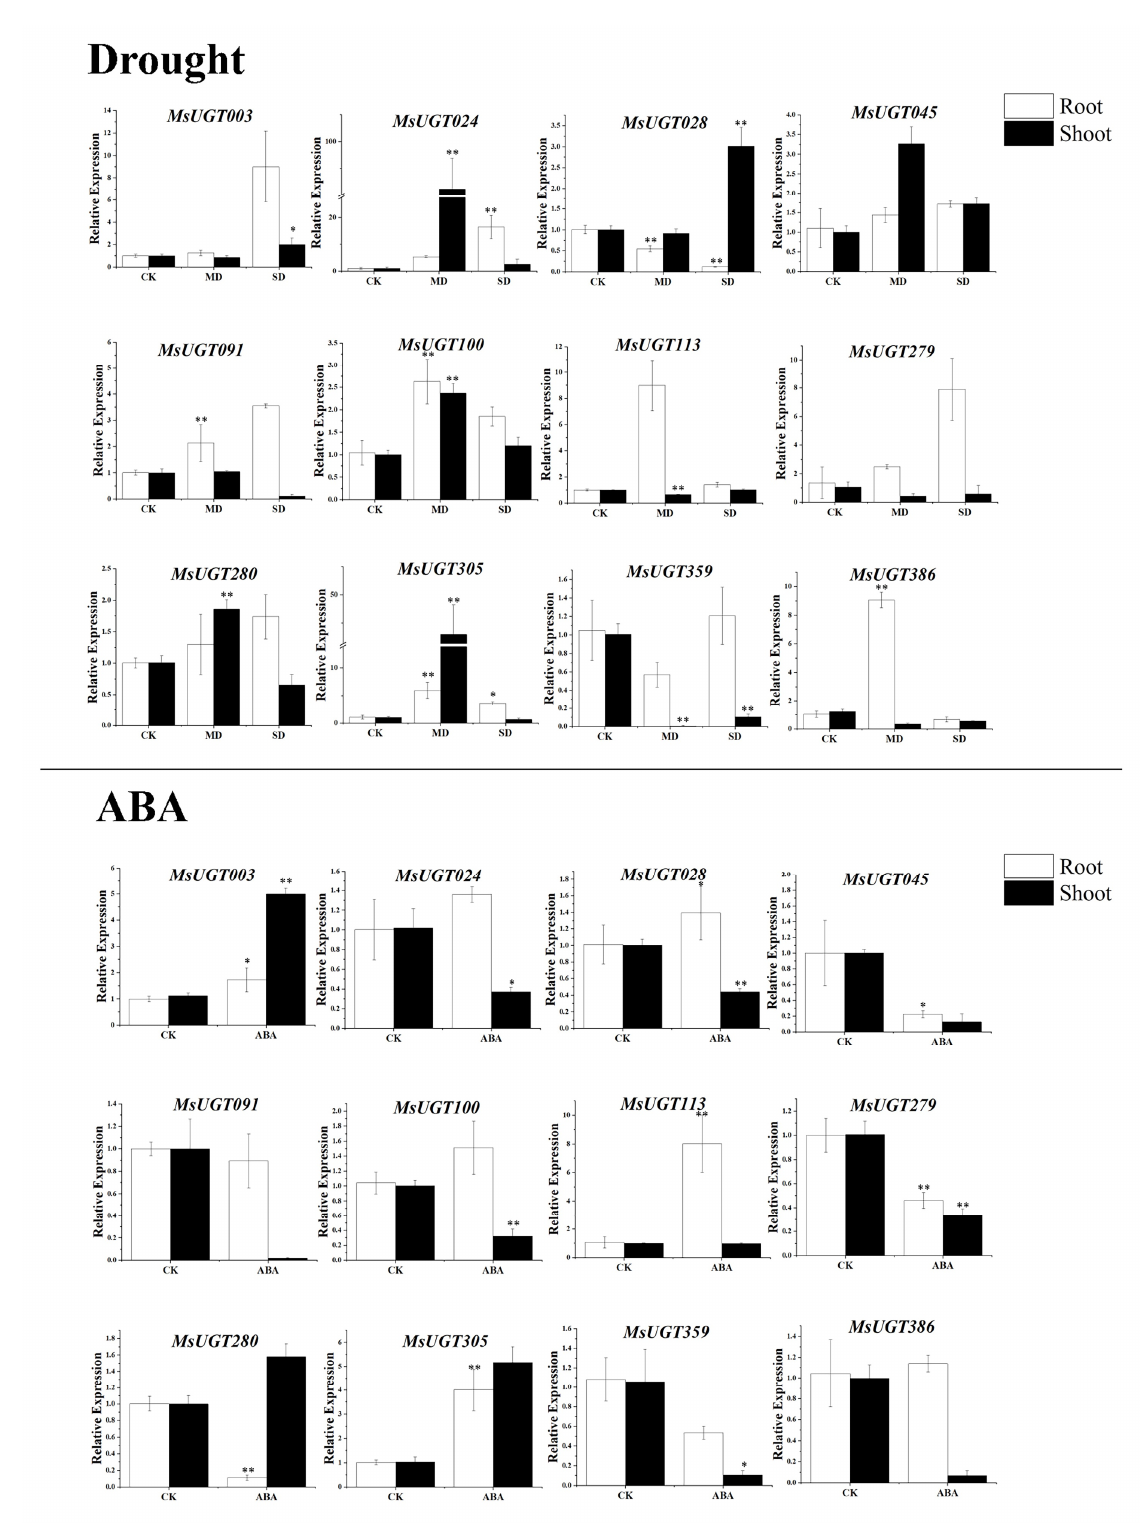
Figure 6. qRT-PCR results of the relative expression of twelve selected MsUGT genes in response to drought stress and ABA treatment in shoot and root. CK, MD, SD and ABA represent the control condition, mild and severe drought and ABA treatments, respectively. Asterisks indicate the significance compared with CK; * represents significant ( p < 0.05) and ** represent highly significant ( p < 0.01). The error bars indicate the standard errors of three biological